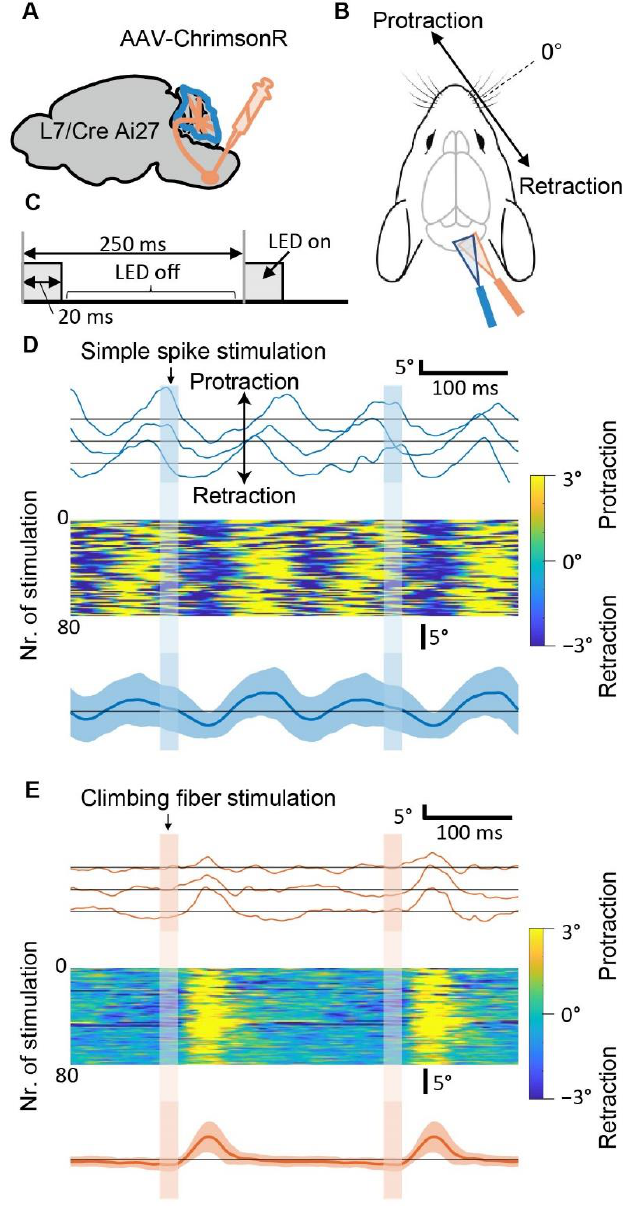
Figure 2. Optogenetic stimulation of Purkinje cells can induce specific patterns of whisker movement. ( A ) Schematic of AAV-ChrimsonR injection in the inferior olive in L7 Cre ;Ai27 mice. The blue area highlights the cerebellar cortex, in which SS rates increase upon stimulation by a blue LED light. The climbing fibers from the inferior olive are sensitive to orange LED light. ( B ) Schematic of the experiment. Cerebellar lobules are stimulated with either an orange or blue LED, during which whisker movements are captured with a high-speed camera (1 kHz). ( C ) Schematic of the stimulation paradigm. ( D ) The upper panel shows whisker traces of three consecutive stimulations of the paramedian lobule at 4 Hz (blue lines). Below, are shown all 80 whisker traces of this experiment and the resulting mean whisker movement for an exemplary mouse. Shaded areas indicate mean ± SD. ( E ) is similar to ( D ) but with orange LED stimulation of the climbing fibers (orange lines).